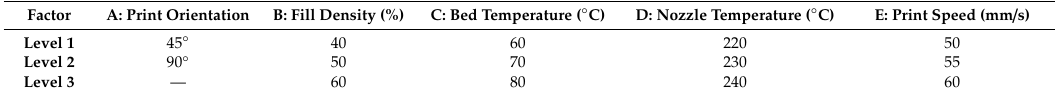
Table 1. Parameters used for the 3D printing of carbon fiber-filled polylactide (CFR-PLA)